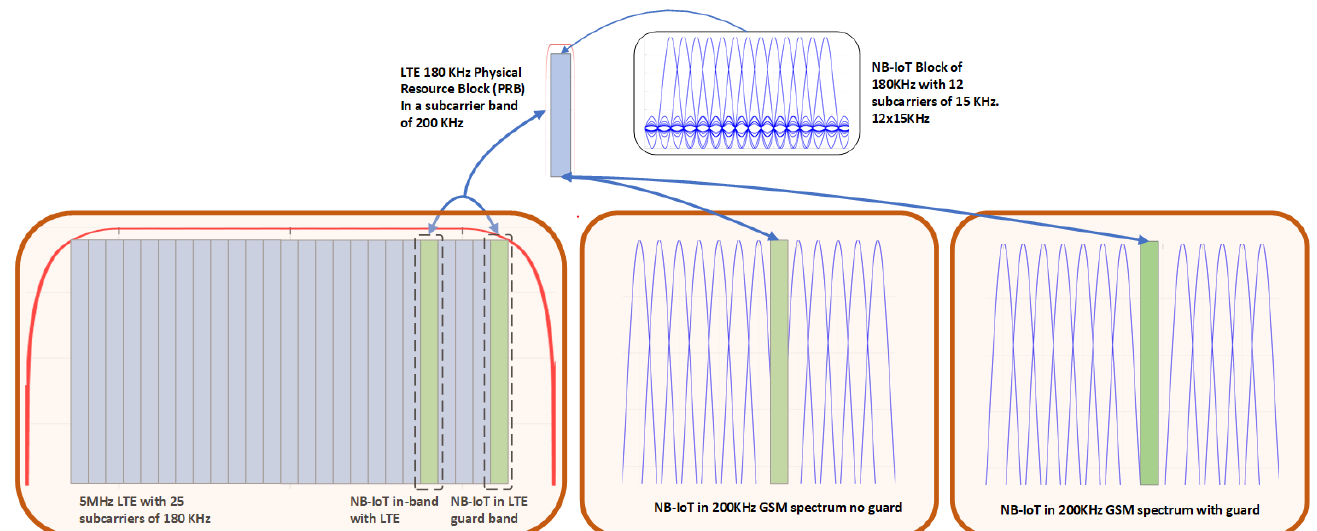
Figure 1. Typologies of NB-IoT deployment, namely stand-alone, in-band, and guard-band deployments. All these deployment configurations are compatible with the channelization that is used in contemporary mobile communication standards, such as GSM/2G (200kHz channel) and LTE/4G (180kHz Physical Resource